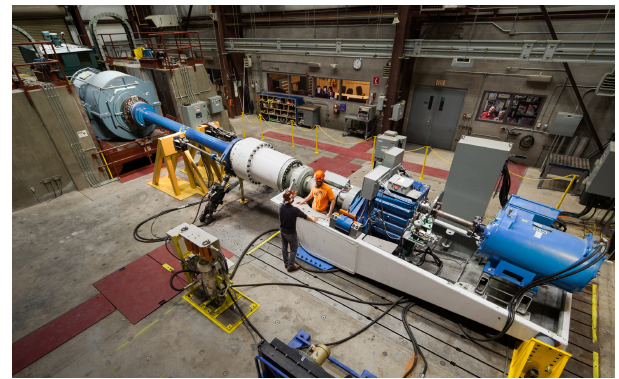
Figure 3. Installation of the GRC drivetrain in the dynamometer. Photo by Mark McDade, NREL